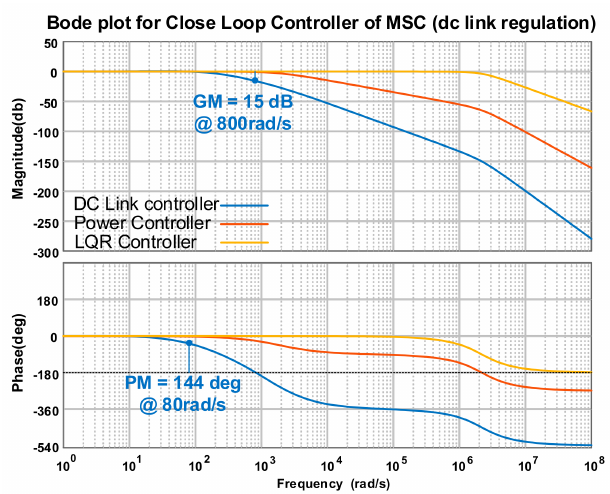
Figure 7. Frequency response plots of the control loops for the